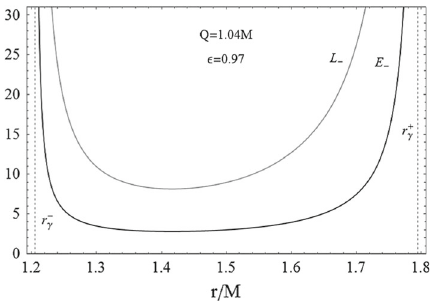
√ √ Fig. 17 Class : 5 /( 2 6 ) M < Q < ( 3 6 / 7 ) M and M / Q ≤ (cid:2) < 1. Parameter choice is as follows: Q = 1 . 04 M and (cid:2) = 0 . 97, Then (cid:9)(cid:9) (cid:2) + = 0 . 866828, M / Q = 0 . 961538, r − γ = 1 . 20538 M , and r + γ = 1 . 79462 M . Circular orbits exist with L = L + ( gray curve ) and E = E + ( black curve ) in r − γ < r < r + γ